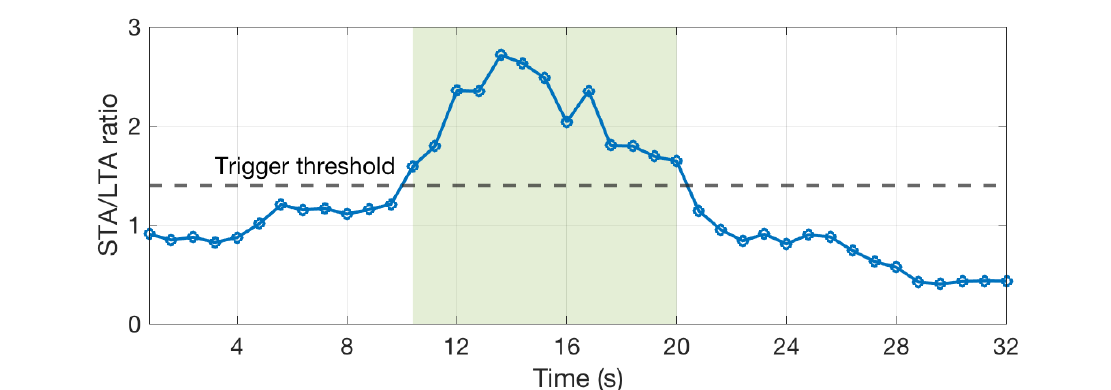
Figure 11. Short Term Average over Long Term Average (STA/LTA) computed from the ratio Figure 10.